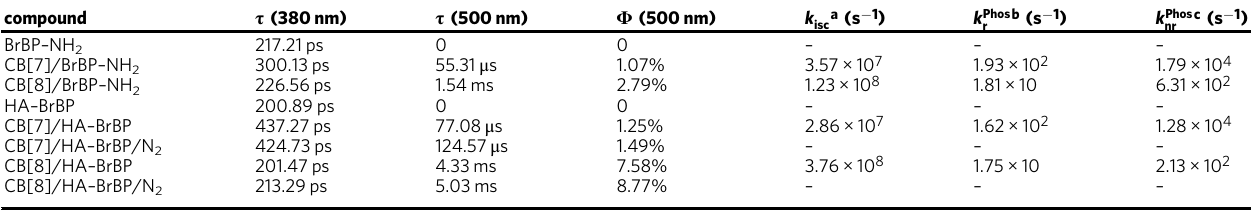
The concentrations of BrBP – NH 2 , CB[7] and CB[8] were 0.5, 0.5 and 0.25mM, respectively. a The intersystem crossing rate constant k isc = Ф Phos / τ Fluo . b The radiative decay rate constant of phosphorescence k Phos r = Ф Phos / τ Phos . c The nonradiative decay rate constant of phosphorescence k Phos nr = (1 − Ф Phos )/ τ Phos .